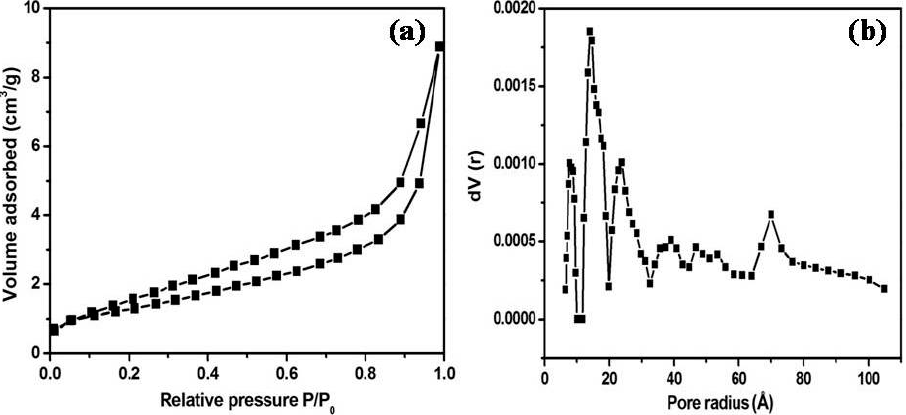
Figure 7. ( a ) Nitrogen adsorption-desorption isotherm and ( b ) DFT pore size distribution curve of MoS 2 /ZnO heterostructure nanorods.